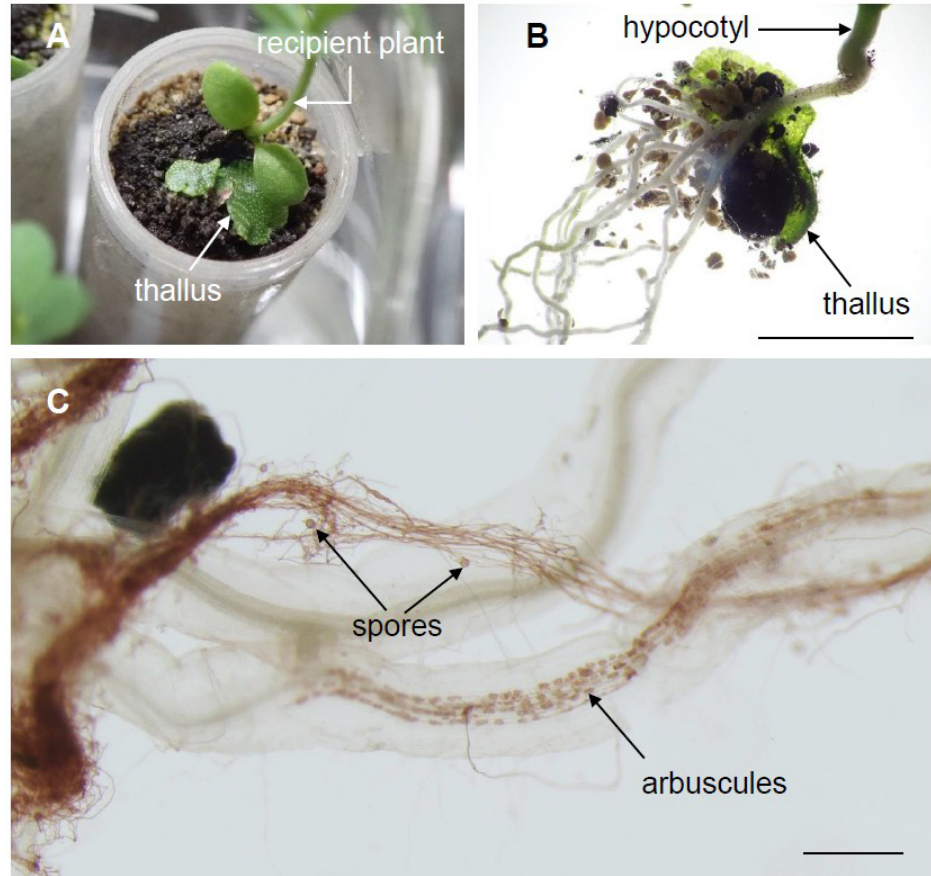
Figure 4. Mycorrhizal thalli as AMF inoculants. ( A ) Image of Lotus japonicas seedlings inoculated with mycorrhizal thalli ( Marchantia paleacea colonized with native AMF), taken at 10 days post-inoculation (dpi). ( B ) Image of mycothalli adhered to L. japonicus root at 10 dpi. ( C ) Roots were stained with 3,3′-diaminobenzidine staining with horseradish peroxidase (HRP)-conjugated wheat germ agglutinin (WGA) (WGA–HRP–DAB) at 10 dpi. Bars = 5 mm ( B ), 0.5 mm ( C ).